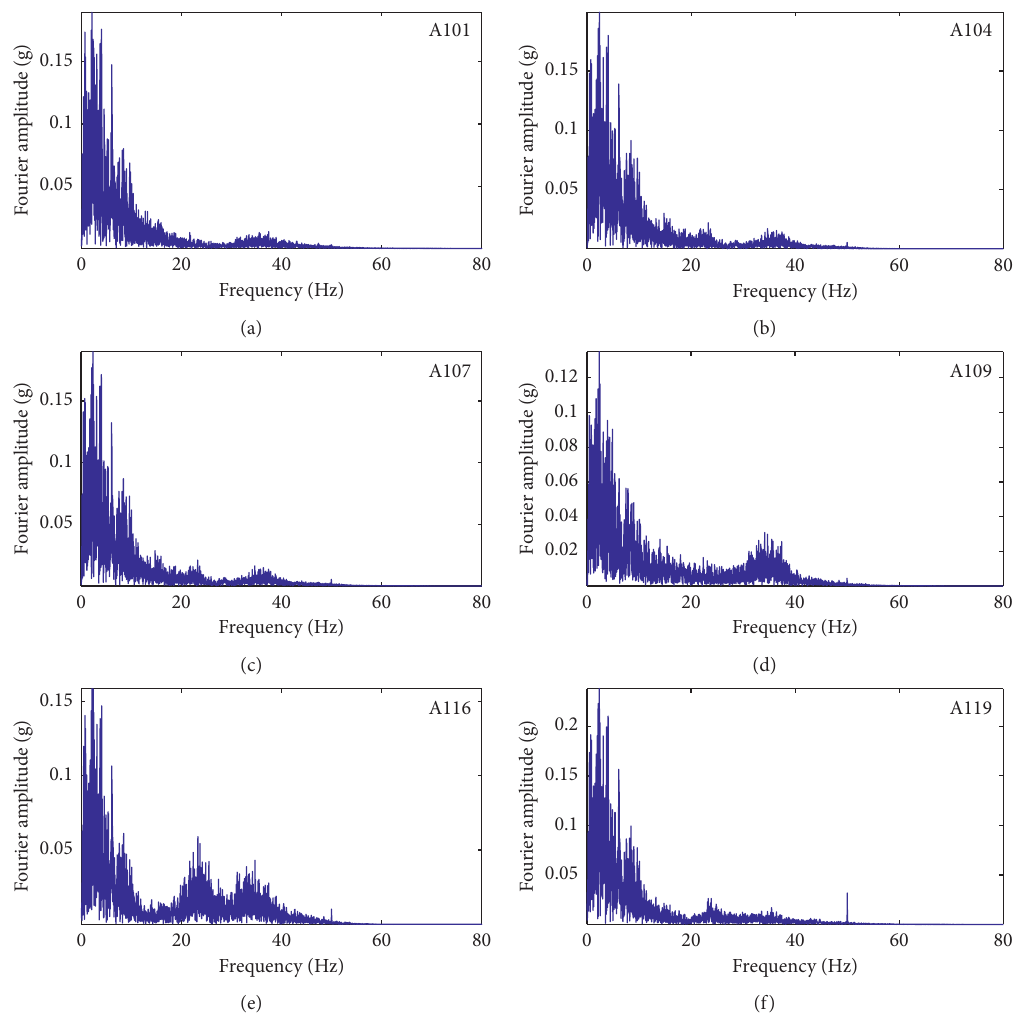
Figure 11: Fourier spectrum of accelerations at different measuring point under PGA of 0.2 g. (a) A101. (b) A104. (c) A107. (d) A109. (e) A116. (f) A119.